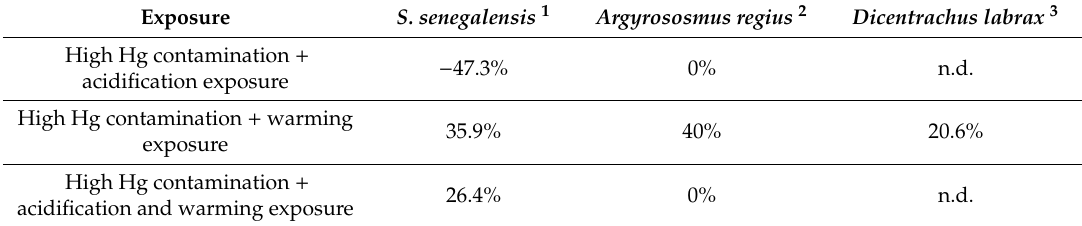
Table 2. Percentage change (in relation to normal temperature and pH conditions) in the contribution of Hg tolerable weekly intake (TWI) (%) accomplished with the consumption of 150 g of three contaminated fish species (muscle) reared under climate change e ff